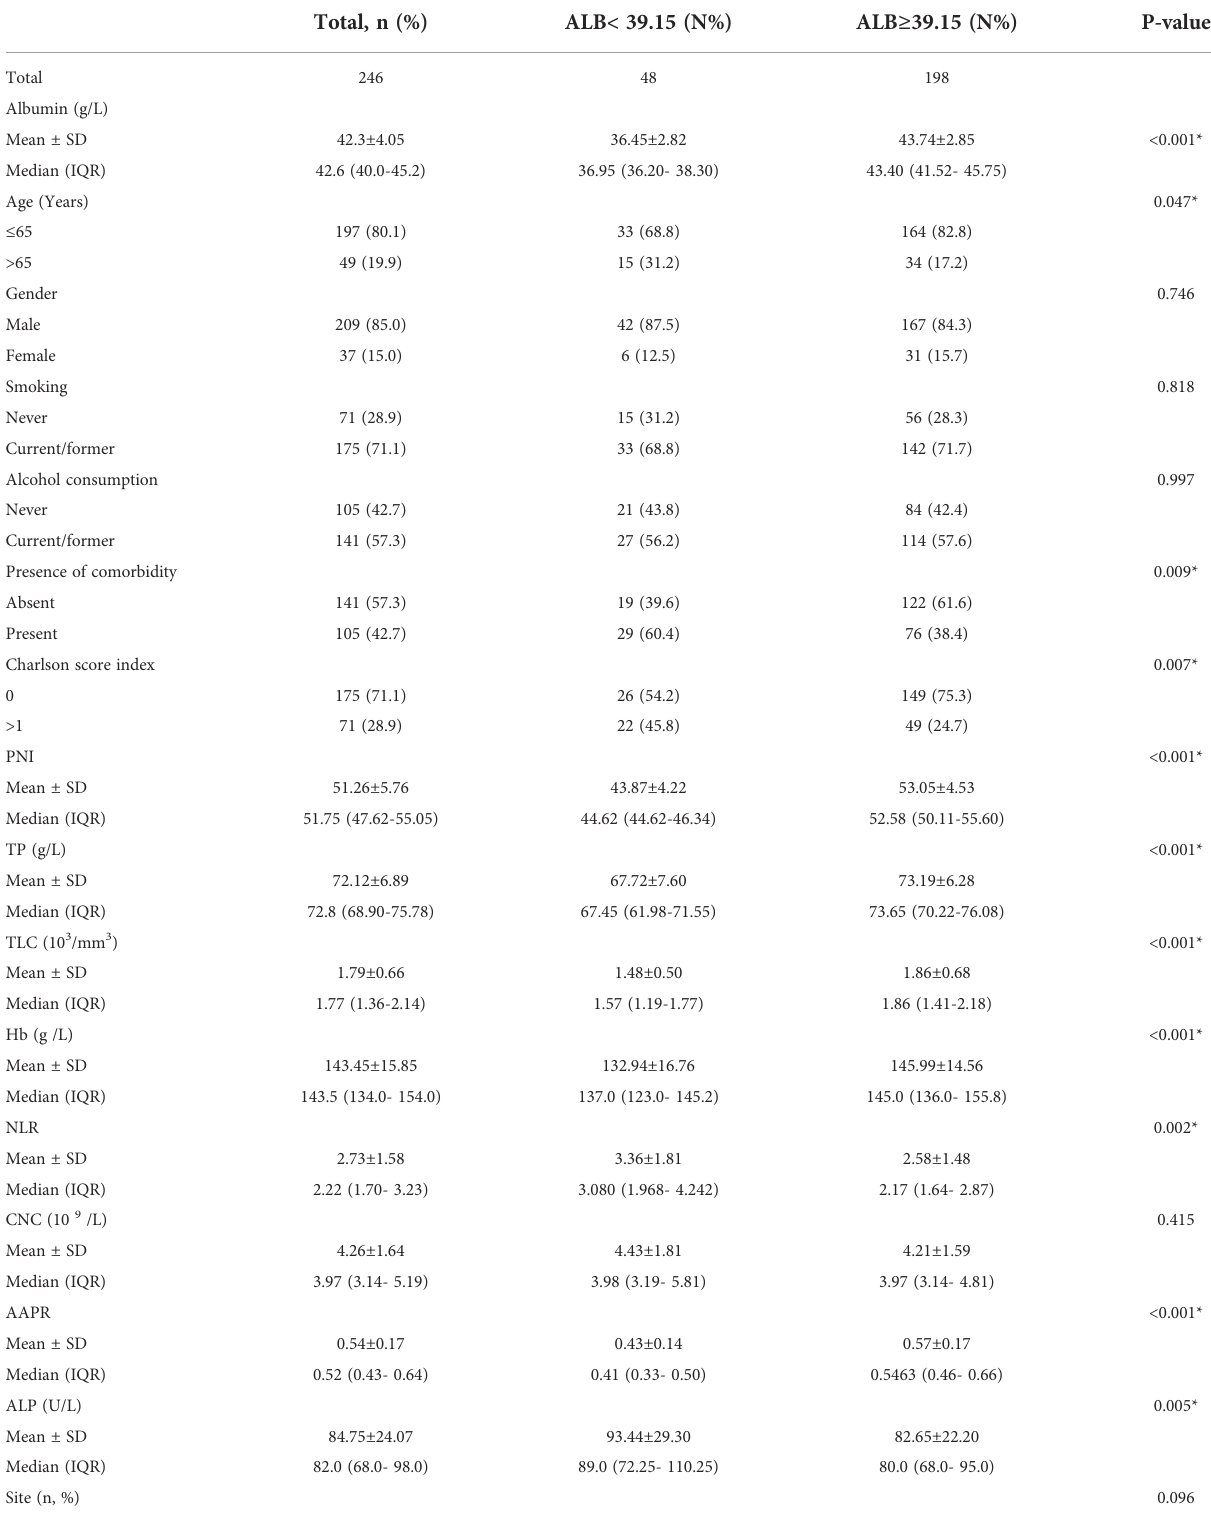
TABLE 2 Baseline characteristics of OPC